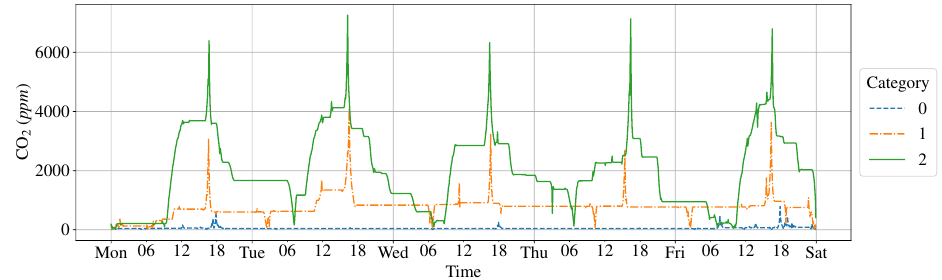
Figure 16. Centroid of raw CO 2 concentration clustering.